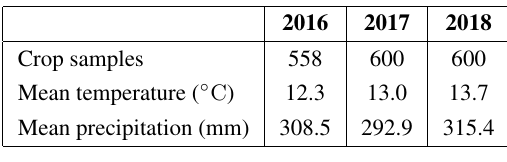
Figure 2. The average temperature was compared for each year and showed that 2018 was 1.4 degrees different from 2016.